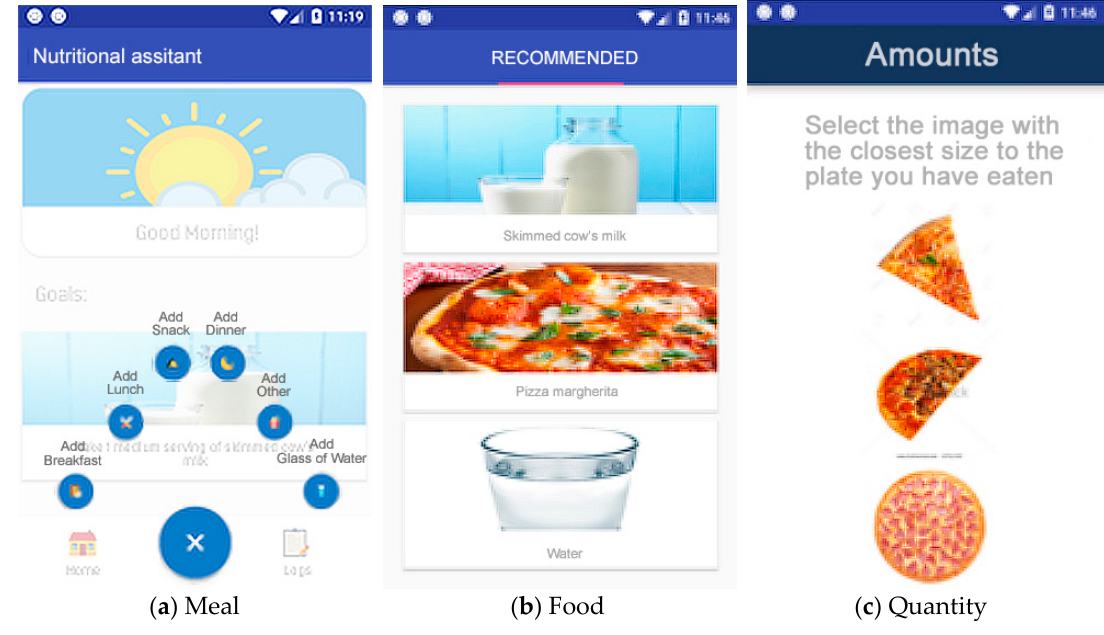
Figure 8. Drop down to register a meal. Sensors 2019 , 19 , x FOR PEER REVIEW